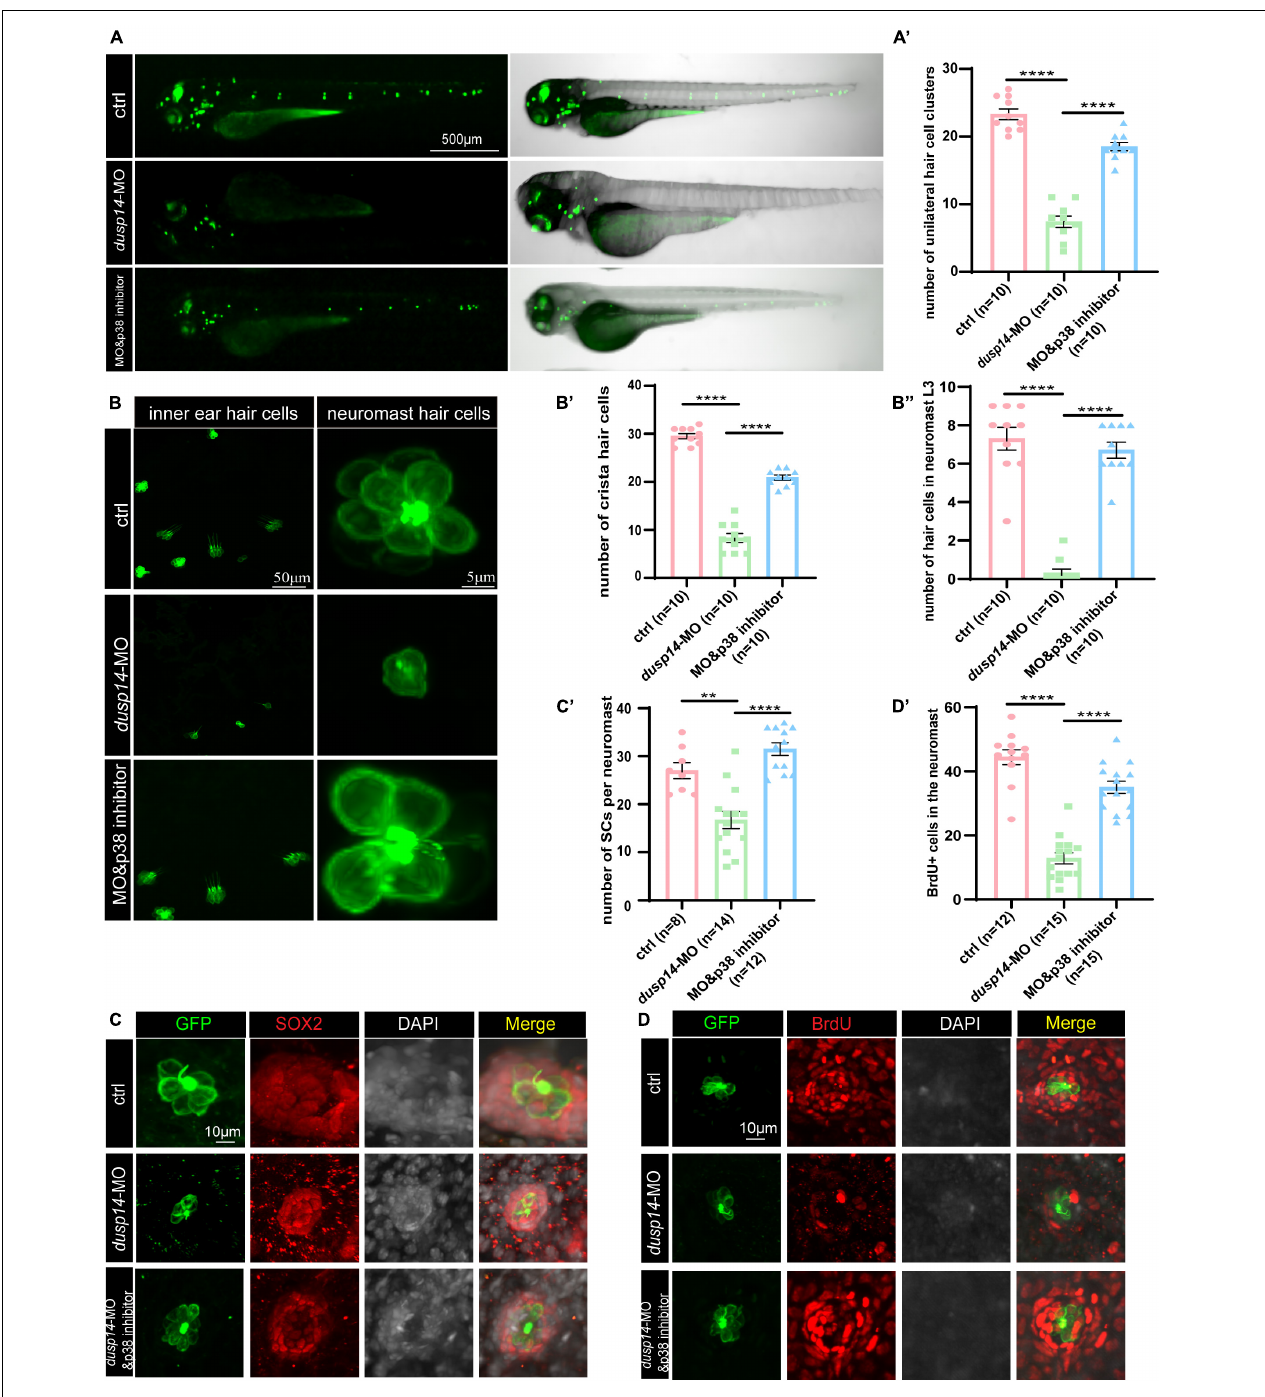
FIGURE 6 | p38 signaling pathway is involved in dusp14 regulation of inner ear hearing in zebrafish. (A) The imaging analysis of control and dusp14 mutants at 72 hpf in bright field and fluorescent field. (A (cid:48) ) Quantification of the number of the unilateral hair cell clusters of control and dusp14 mutants at 72 hpf. (B) Confocal imaging analysis of inner ear hair cells and lateral line neuromast hair cells of control, dusp14 deficiency and dusp14-MO and p38 inhibitor coinjected zebrafish at 72 hpf. (B (cid:48) ) The statistical analysis of the numbers of crista hair cells for panel (B) . (B (cid:48)(cid:48) ) The statistical analysis of the numbers of hair cells in the remaining neuromast L3 for panel (B) . (C) The representation of SOX2 immunofluorescence images of neuromasts in the posterior lateral line of the control, dusp14 morphants and dusp14-MO and p38 inhibitor coinjected zebrafish at 72 hpf. (C (cid:48) ) Quantification of the number of supporting cells per neuromast for panel (C) . (D) BrdU staining for the supporting cells in the neuromasts of the control, dusp14 morphants and dusp14-MO and p38 inhibitor coinjected zebrafish at 72 hpf. (D (cid:48) ) Quantification of zebrafish embryos with the BrdU + cells for panel (D) . Experimental embryos were sampled at 72 hpf ( n > 6). Each bar represents the mean ± SD. Values with ** and **** above the bars are significantly different ( P < 0.01 and P < 0.0001, respectively).